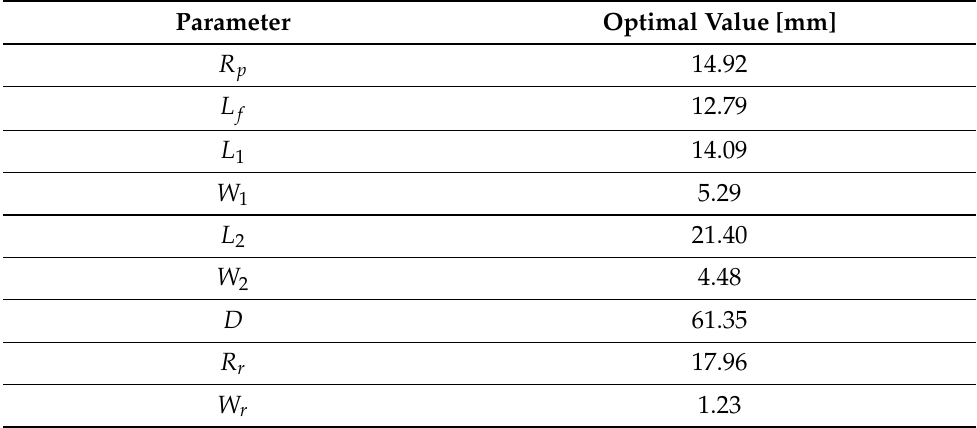
Table 2. Numerical assessment ( [ f min , f max ] = [ 2.3, 2.6 ] [GHz])— SbD -optimized geometric descriptors of the designed WWCS